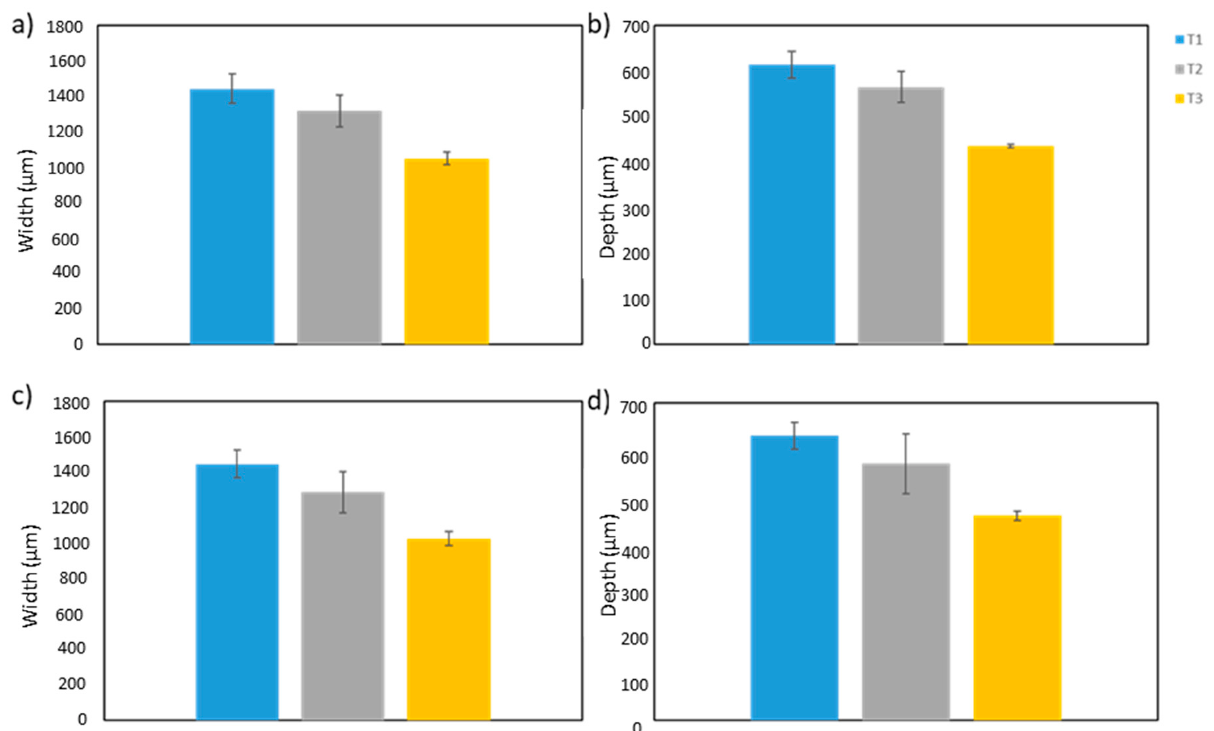
Figure 11. Melt pool ( a ) width at the beginning, ( b ) depth at the beginning, ( c ) width at the end, and ( d ) depth at the end.